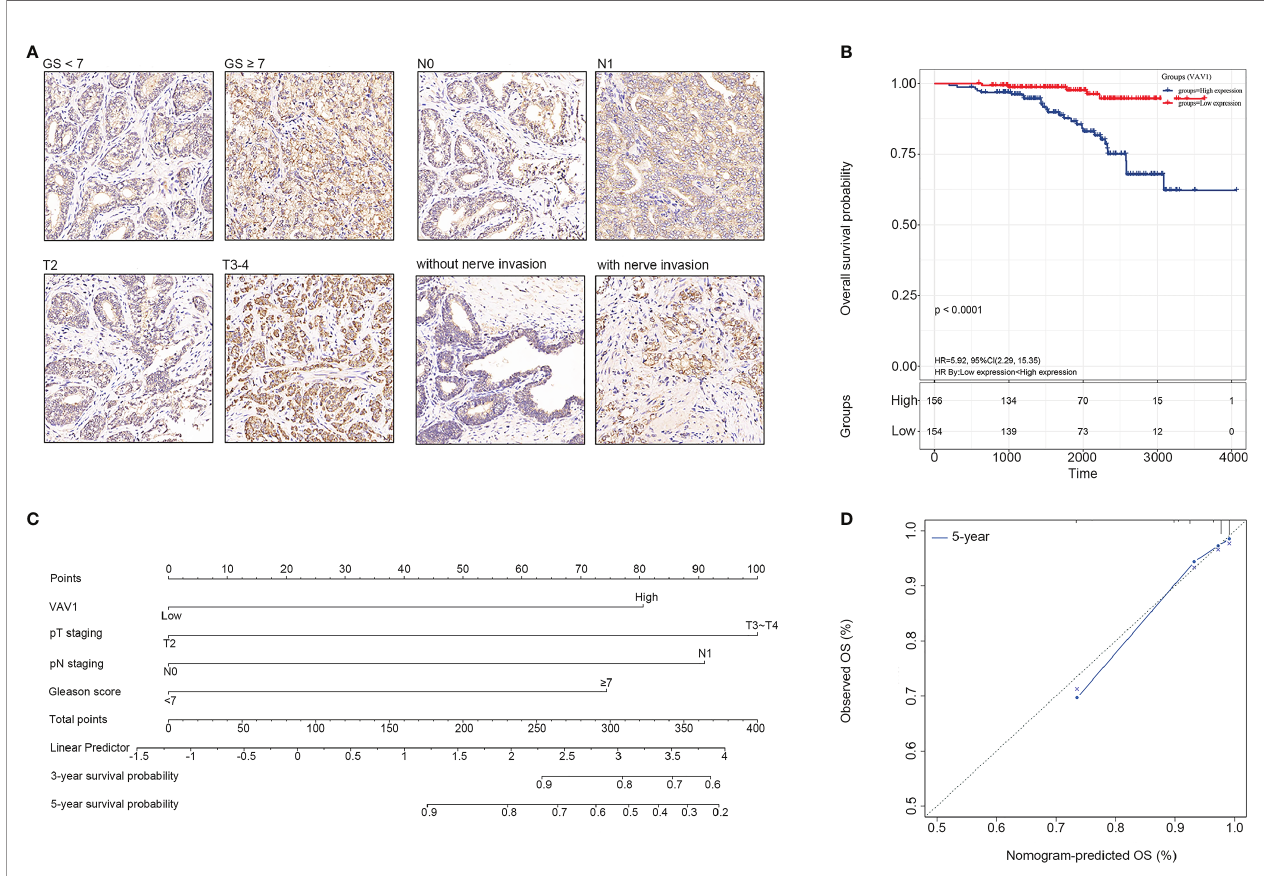
FIGURE 5 | Experimental veri fi cation of VAV1 in PCa tissue microarray (TMA). (A) The protein expression and localization of VAV1 in PCa TMA. (B) Kaplan – Meier curves for the PCa tissues from patients with high and low expression of VAV1 in TMA data. (C) Nomogram integrating VAV1, GS, and pTNM to predict the probability of 3- and 5-year OS for PCa patients in TMA data. (D) The calibration curve shows that the nomogram model has a better predictive effect on the 5-year OS of PCa patients in TMA